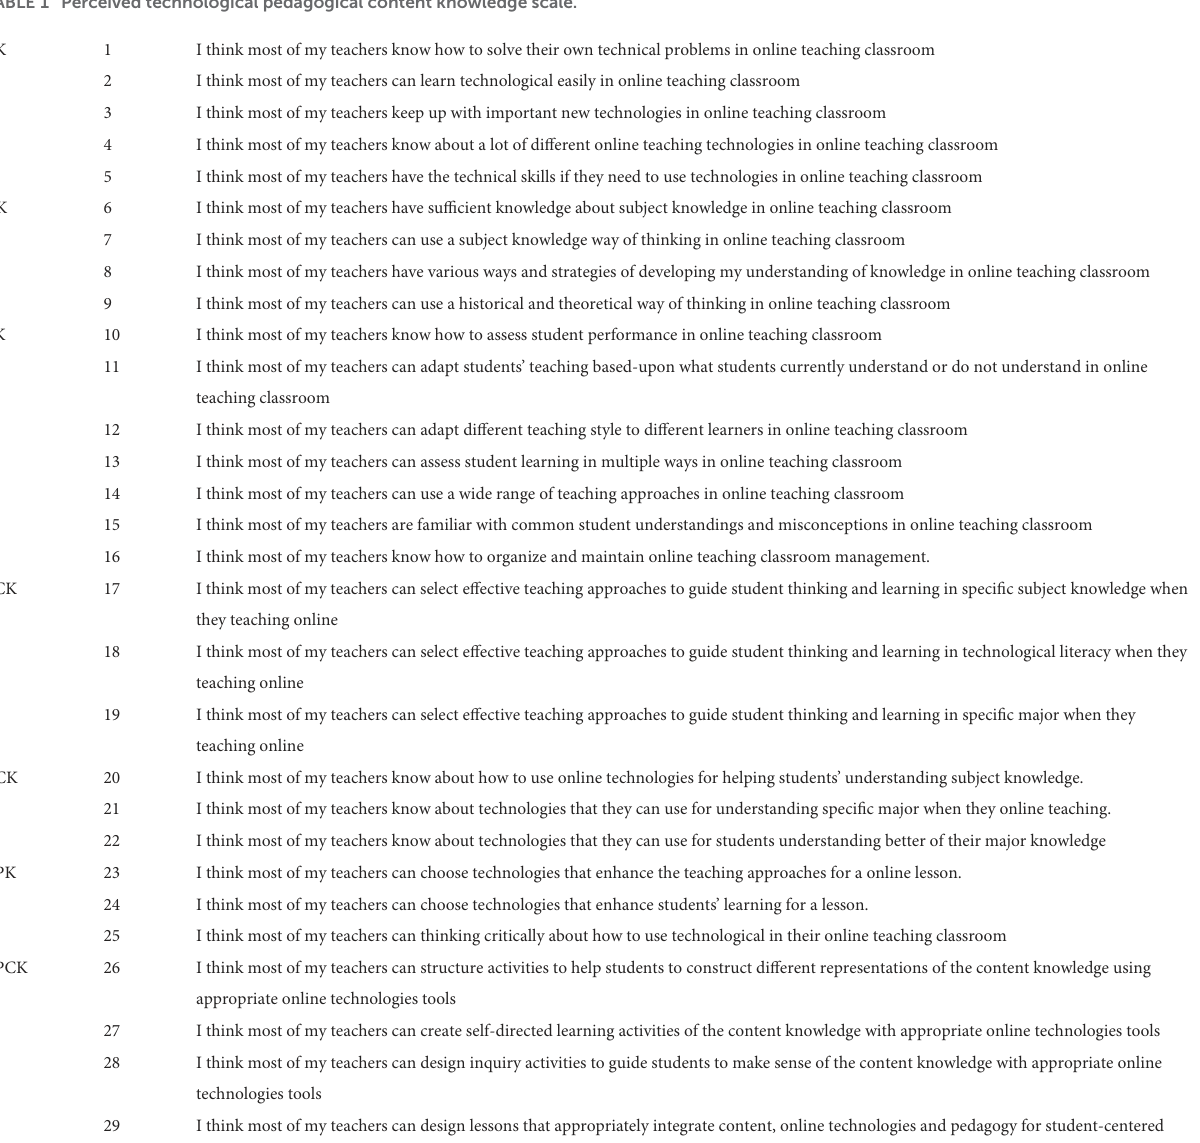
TABLE 1 Perceived technological pedagogical content knowledge